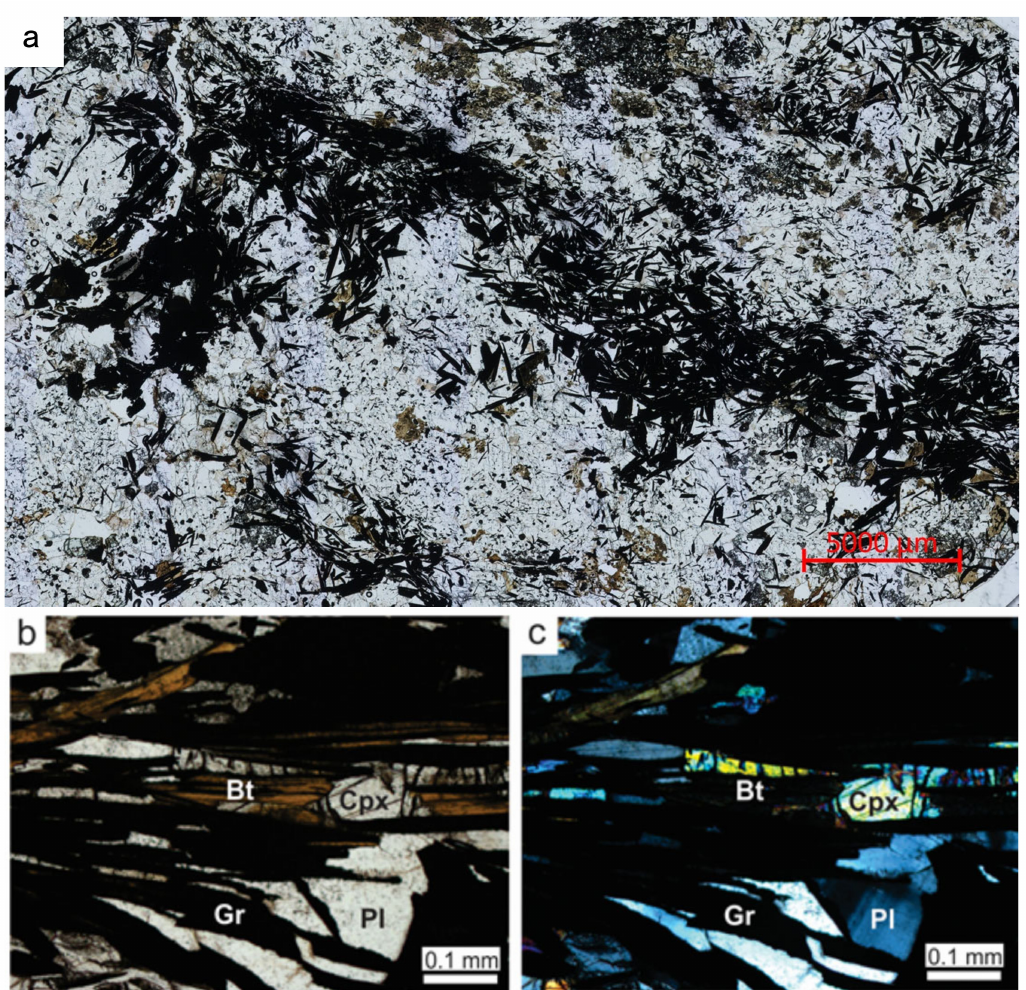
Figure 5. Micrographs of graphite schist: ( a ) mosaic micrograph covering a whole thin section c. 2.5 × 3.5 cm, showing the distribution crystal shape and size of the of the graphite (black flake crystals). Note the inhomogeneous nature of the aggregates of graphite crystals. Modal content is 29%. (Sample HG11-15). B–C typical graphite schist assemblage of graphite (Gr), biotite (Bt), clinopyroxene (Cpx), and plagioclase (Pl), where with foliation defined by oriented graphite crystal flakes and biotite. ( b ) Plane light and ( c ) polarized light. Sample